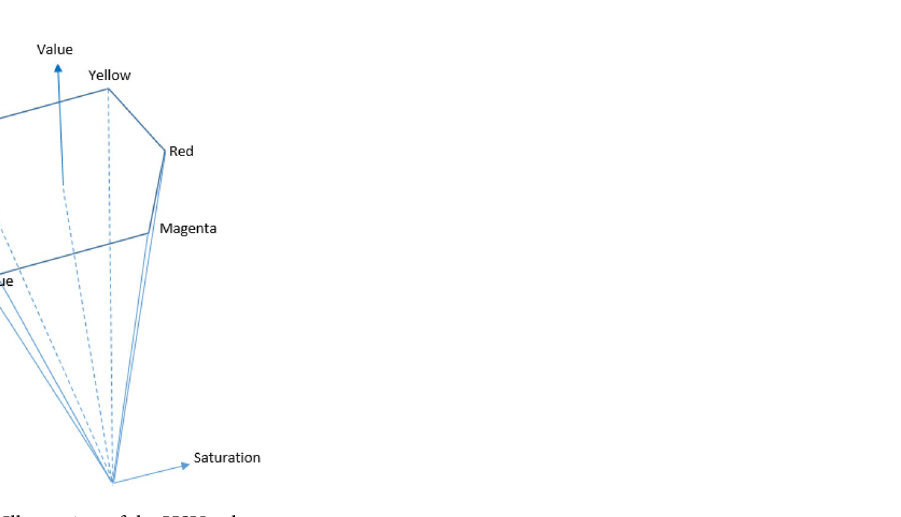
Figure 2. Illustration of the HSV color